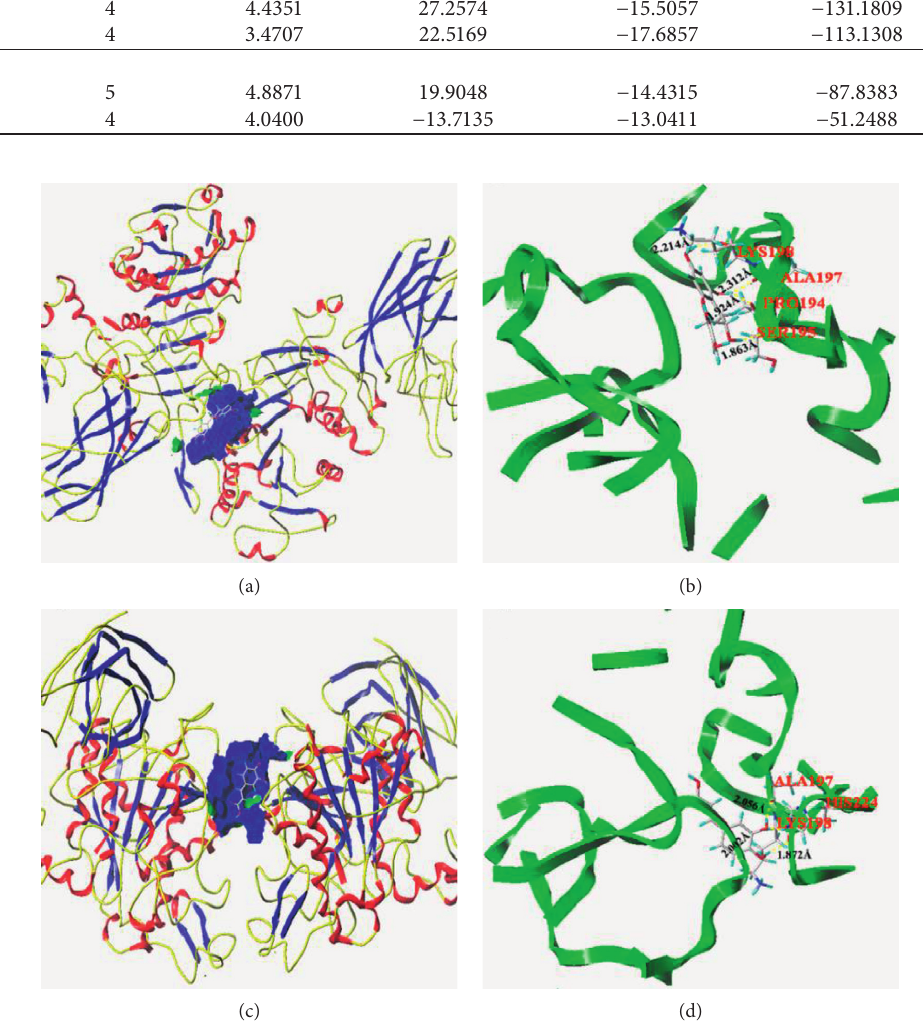
Figure 3: The molecule docking results of catechin and caffeic acid with pancreatic lipase. (a) Catechin binds with the active site of pancreatic lipase. (b) Catechin interacts with amino acid residues. (c) Caffeic acid binds with the active site of pancreatic lipase. (d) Caffeic acid interacts with amino acid residues. Two phenolic standards appeared in ball and stick models, amino acid residues are represented by green capped stick models, and short dotted yellow line stands for hydrogen